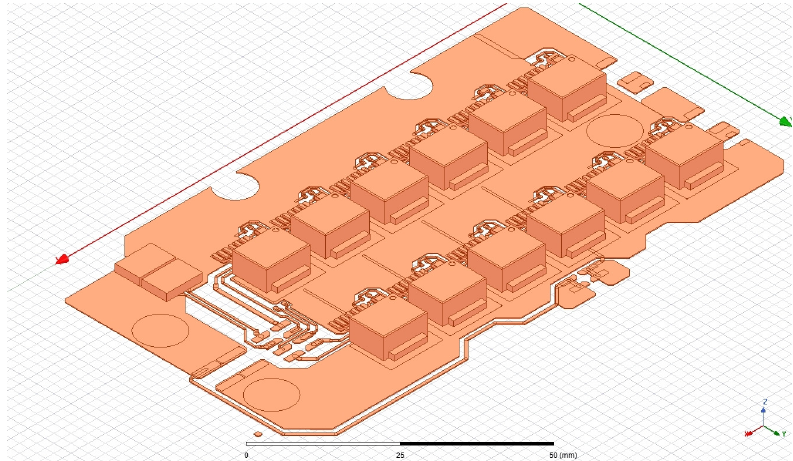
Figure 2. Definition of the materials of the 3D components in Q3D Extractor and identification of the PCB copper tracks.